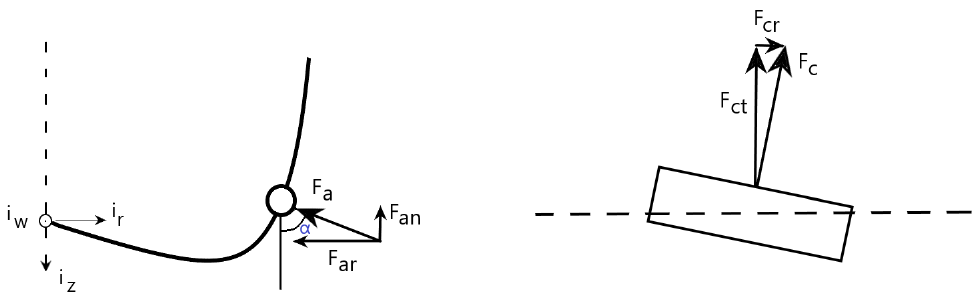
Figure 9. Force decomposition on a single cutter along tangential and normal